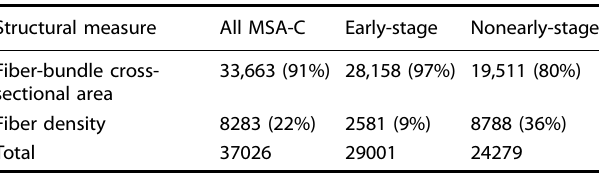
Table 2. Quantitative analysis in fi ber-bundle cross-sectional area and fi ber density of MSA-C. Structural measure